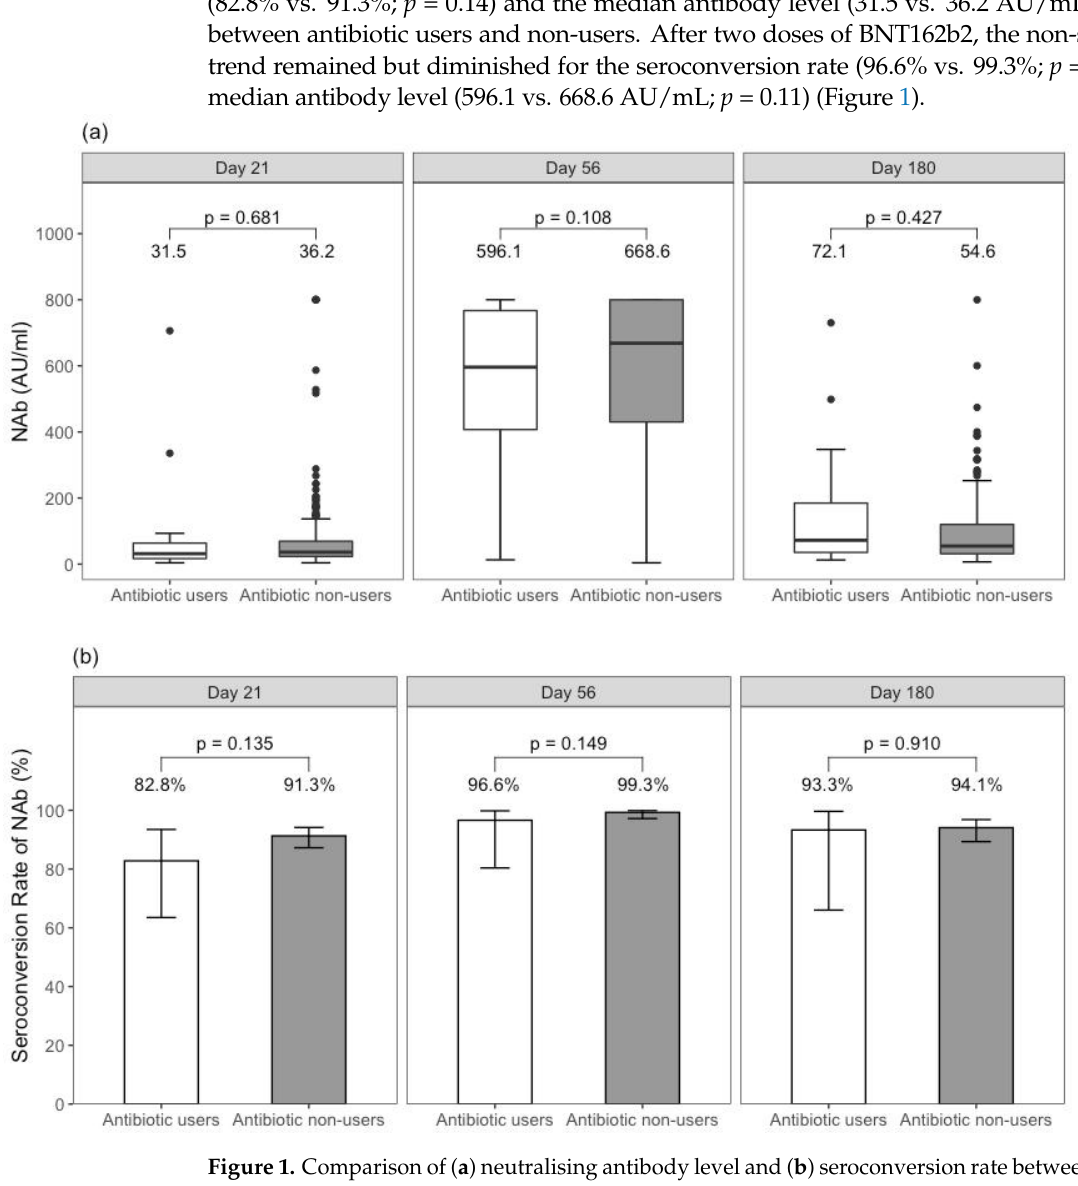
Table 3. Risk factors for the seroconversion of neutralizing antibody among BNT162b2 recipients.